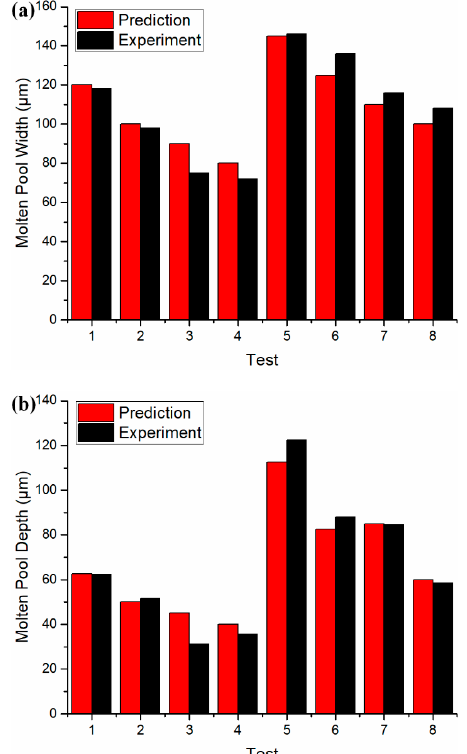
Figure 9. Validation of calculated molten pool dimensions to the experimental measurements under different process conditions. ( a ) Molten pool width, ( b ) molten pool depth.